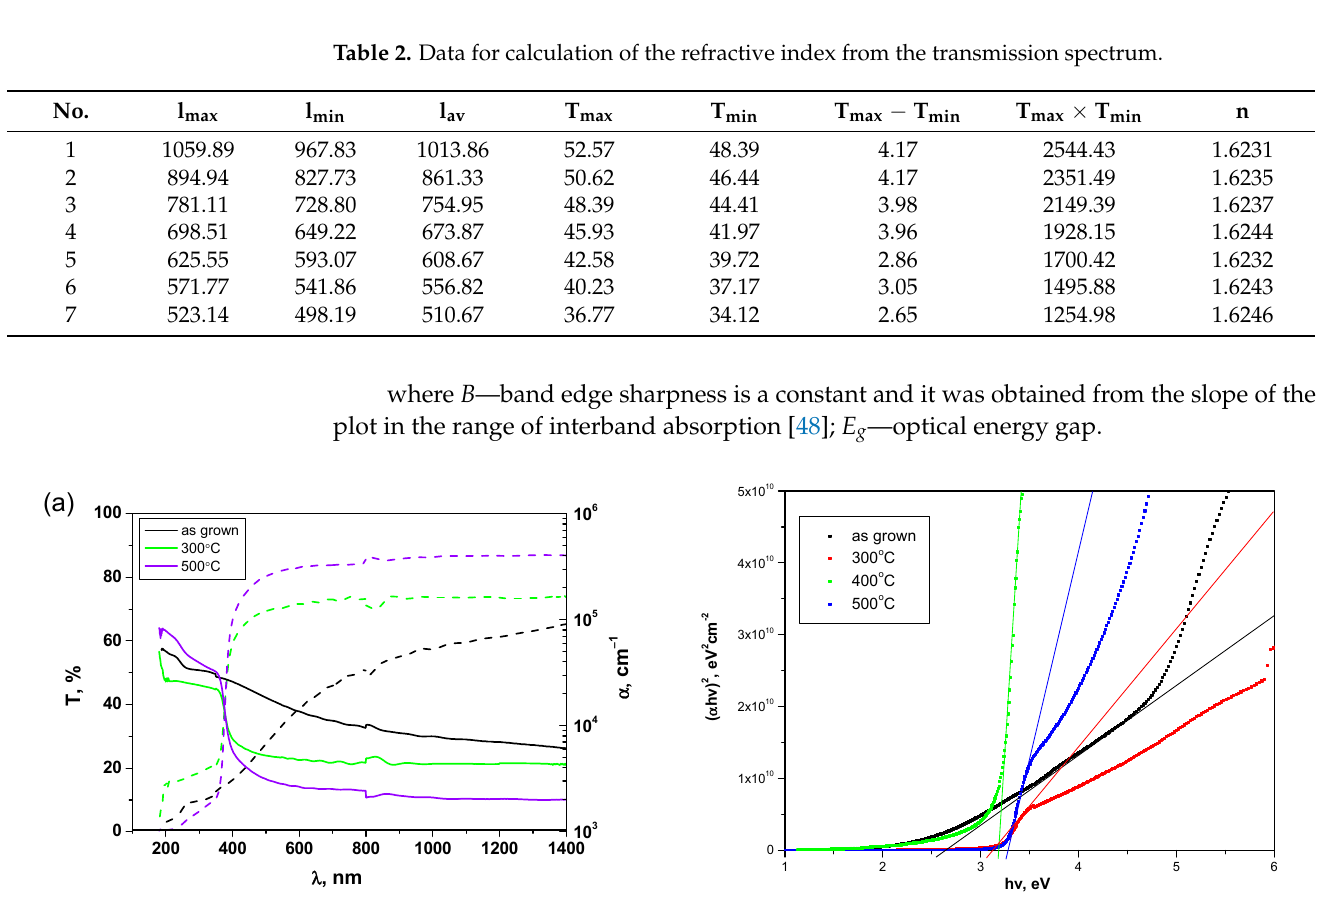
Figure 5. ( a ) Optical transmission spectra (dashed line) and layer absorption coefficient (solid line) at different annealing temperatures; ( b ) The Tauc plot of layers at different annealing temperature. The calculated values of the optical band gap are, respectively, 2.63 eV (for as grown), 3.11 eV (annealed at 300 °C), 3.15 eV (annealed at 400 °C), and 3.28 eV (annealed at 500 °C). The obtained values of the optical band gap of ZnO:Co (Figure 5b) are smaller